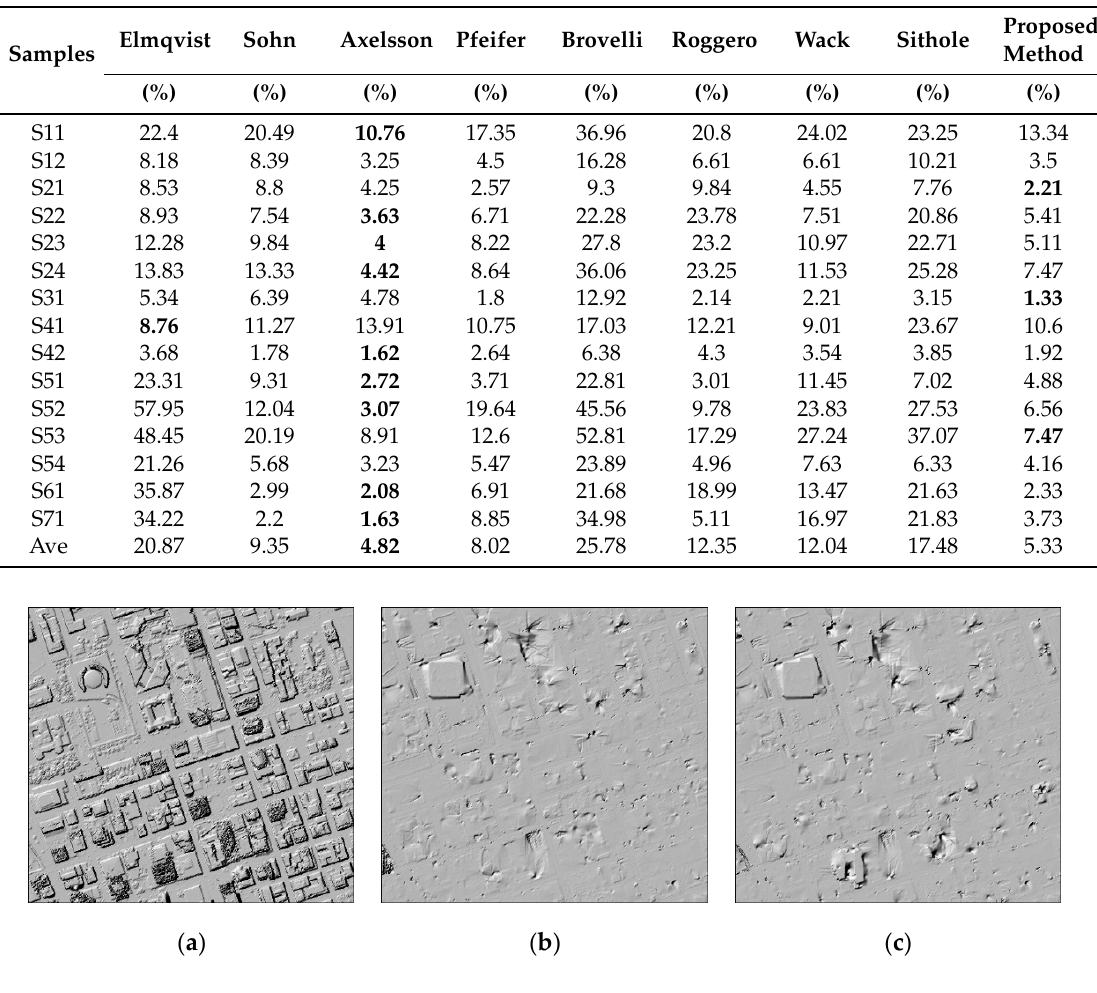
Table 2. Comparison of total errors of the proposed method and the eight classical filtering for all study samples (the bold value is the smallest one in each line). Samples